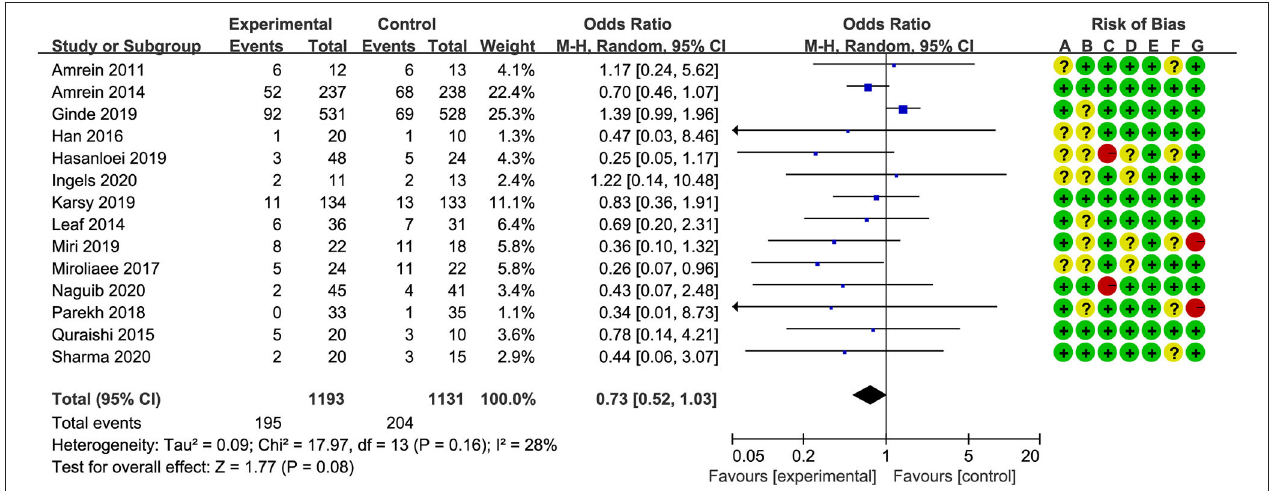
FIGURE 2 | Effect of vitamin D administration on mortality in critically ill patients [risk of bias: (A) random sequence generation; (B) allocation concealment; (C) blinding of participants and personnel; (D) blinding of outcome assessment; (E) incomplete outcome data; (F) selective reporting; (G) other